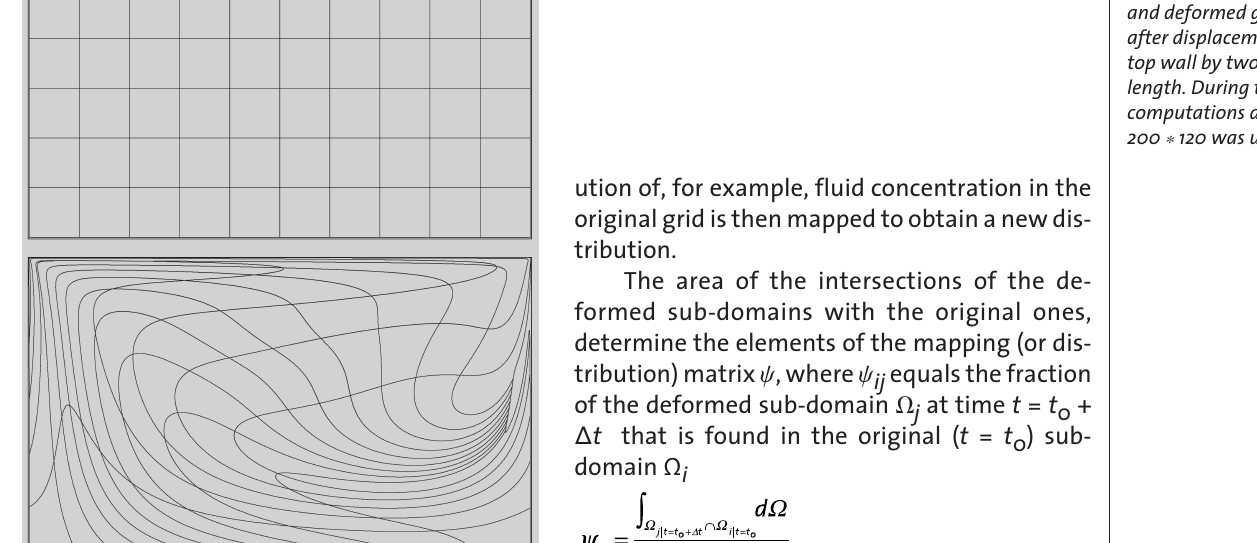
Figure 4 (upper): Initial sub-domain discretization 10 * 6 grid; and deformed grid (below) after displacement of the top wall by two times its length. During the actual computations a finer 200 * 120 was